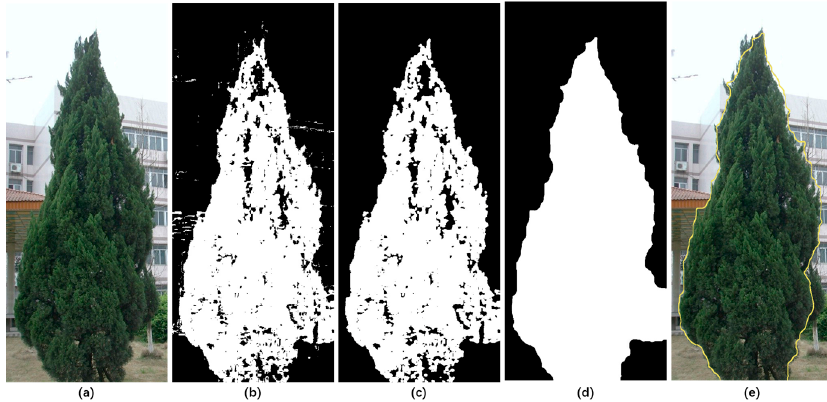
Figure 7. The segmentation of tree from background: ( a ) original image; ( b ) the extracted region by H value (between 90–150°); ( c ) the result of morphological opening to (b); ( d ) the result of morphological closing to (c); ( e ) the outline of segmented tree.